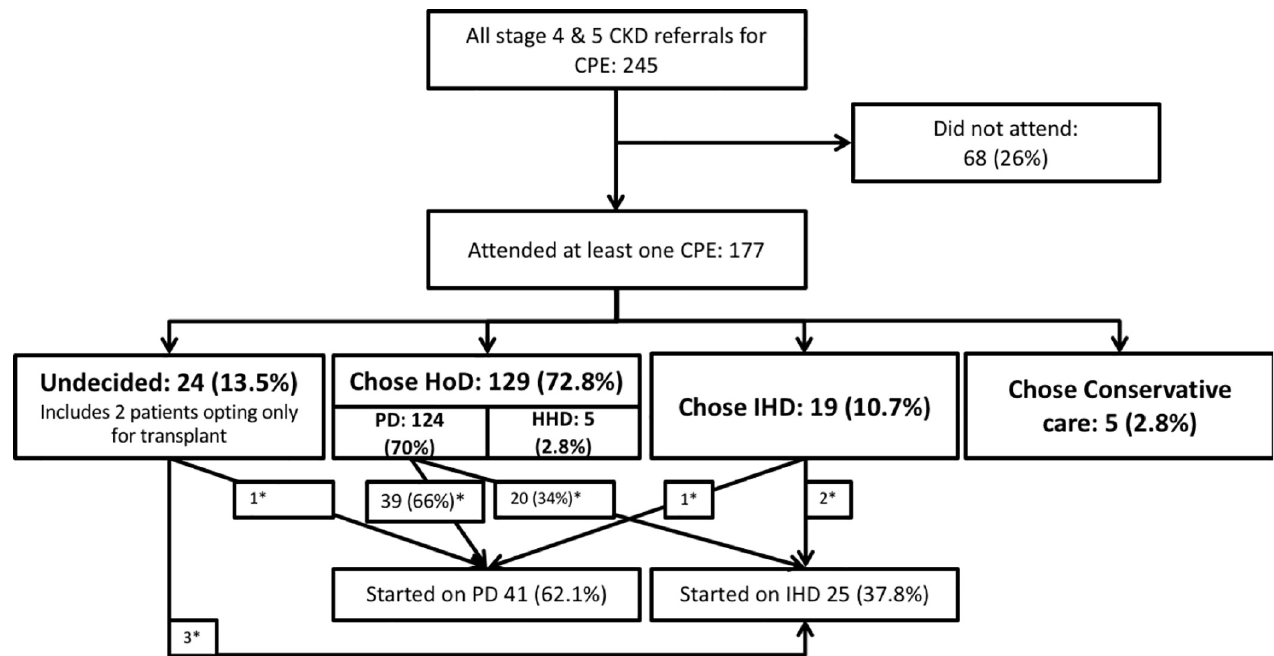
Fig 3. Flow-chart showing patient attendance patterns in a universal CPE program. � Reflects the no. of patients (%) who initiated renal replacement therapies at the end of the follow up period; CPE: Comprehensive Pre-ESRD patient Education; HoD: Any form of home dialysis; IHD: In-Center